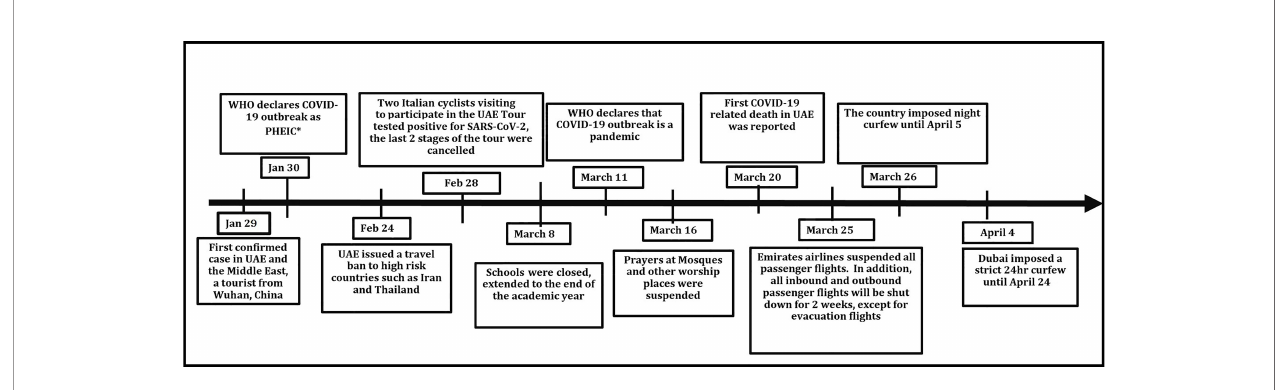
FIGURE 3 | Timeline of COVID-19 outbreak